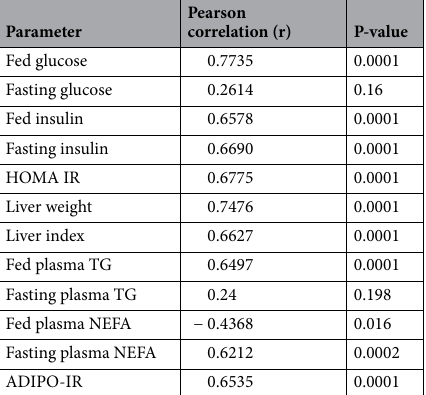
Table 5. Pearson correlations between liver-fat content and metabolic factors measured in